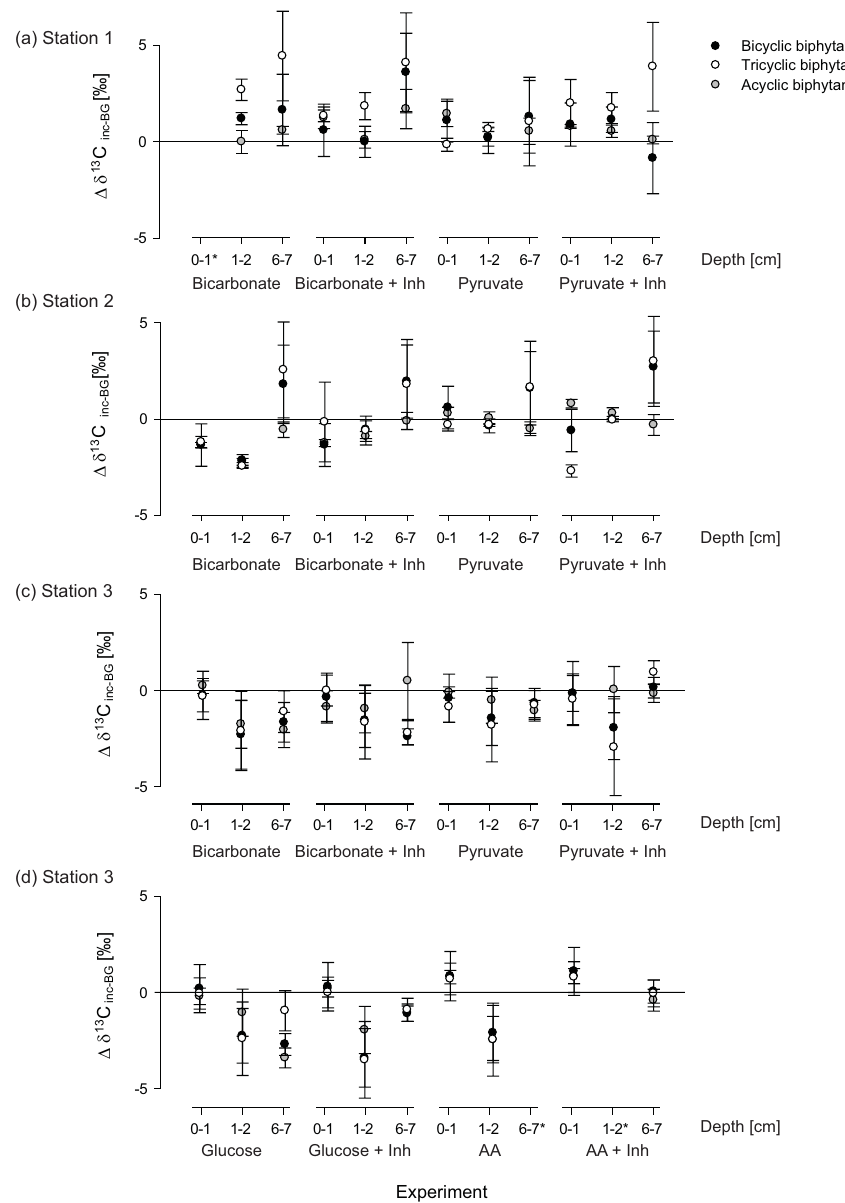
Fig. 6. Difference in δ 13 C-values ( 1δ 13 C inc − bg ) of the acyclic, bicyclic and tricyclic biphytanes in ‰ in the cores incubated with labeled substrate versus the δ 13 C values in the background cores (incubated with and without inhibitor) at station 1 (a) , station 2 (b) and station 3 (c) from the cores incubated with bicarbonate and pyruvate, with and without inhibitor, and the cores incubated with glucose and amino acids with and without inhibitor, at station 3 (d)